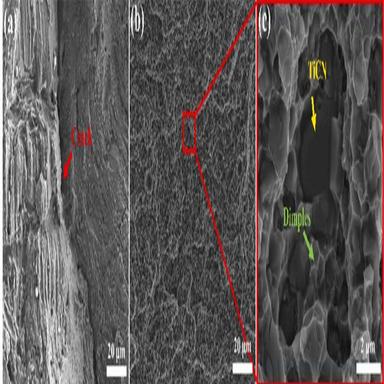
Tensile fractograph of (a) pure 2024 Al alloy, (b) 2024-5 vol% TiCN composite, and (c) 2024-5 vol% TiCN composite at higher magnification.